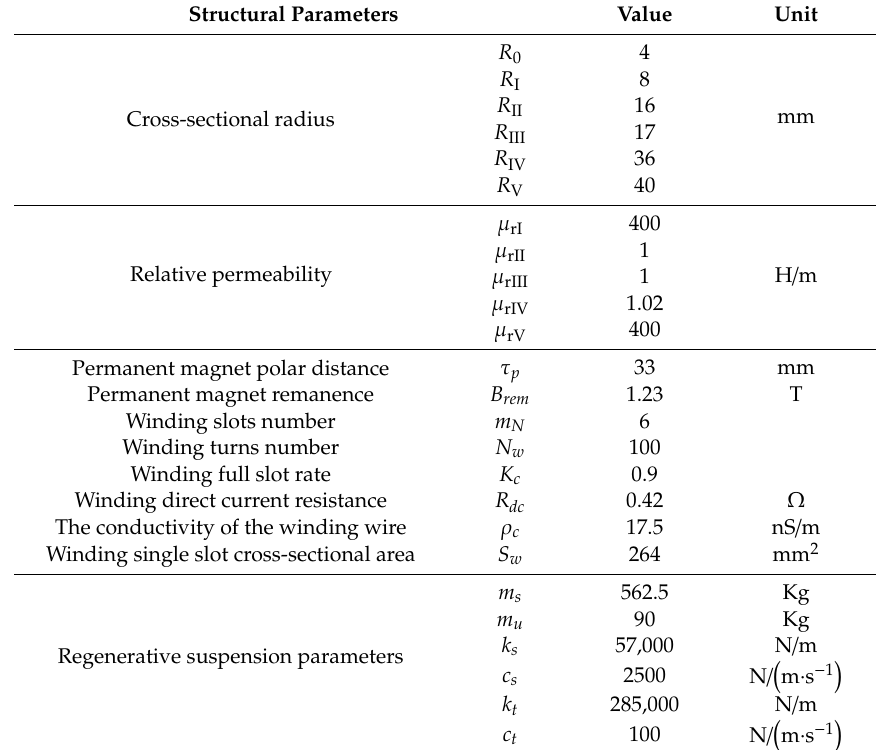
Table 1. Data parameters of 1 / 4 magnetorheological (MR) regenerative suspension [13]. Structural Parameters